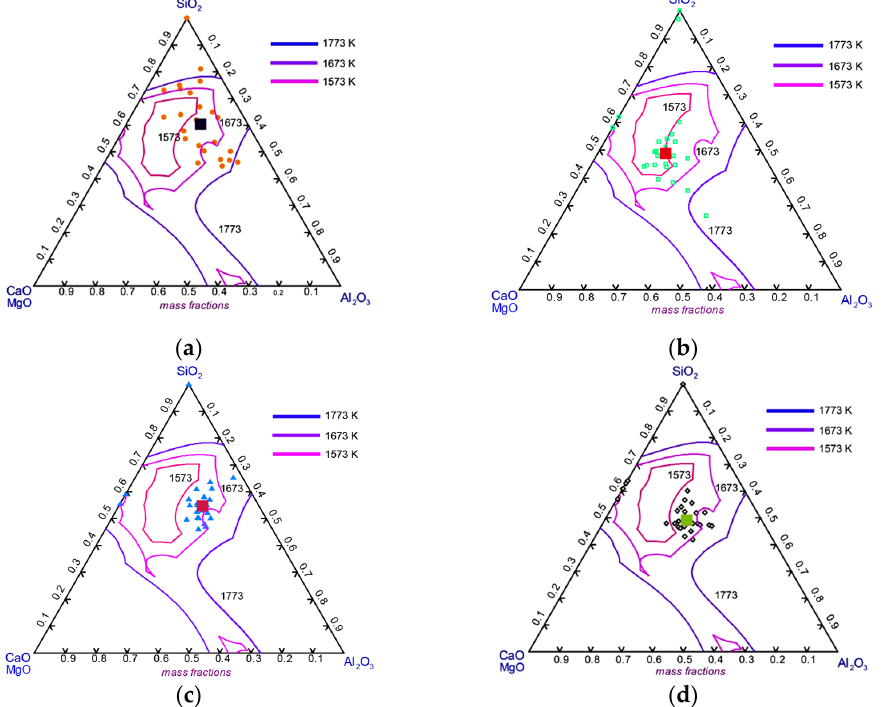
Figure 7. Inclusion distribution overlaid on a phase diagram with the refining slags with different basicities of ( a ) 0.5, ( b ) 0.8, ( c ) 1.0 and ( d ) 1.2.